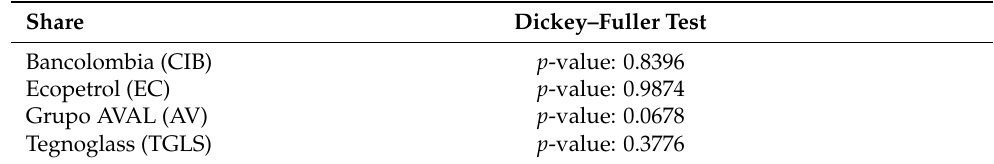
Table 2. Dickey–Fuller test for the non stationarity of cumulative